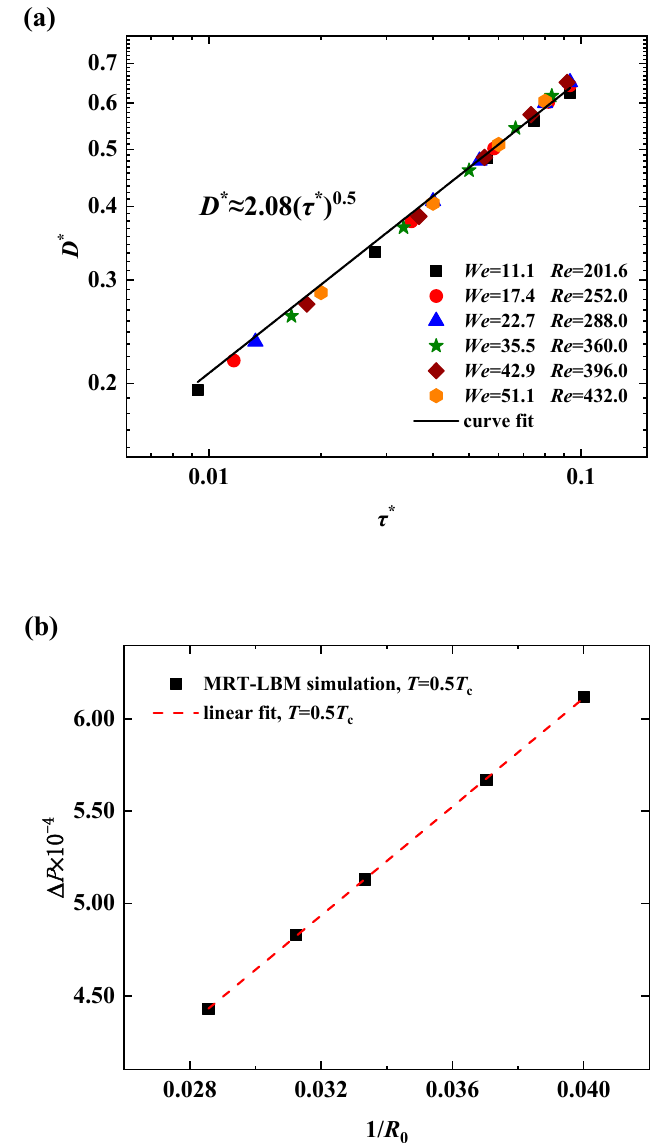
Figure 1. The model validation ( a ) Time evolution of the dimensionless spreading factor in the kinematic phase for six different cases; ( b ) The Laplace law.